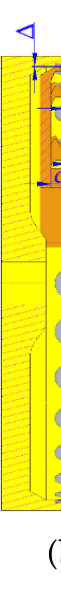
Figure 6. Schematic diagram of structure and installation of the seed-cleaning scraper. ( a ) Schematic diagram of the structure of the seed-cleaning scraper. ( b ) Schematic diagram of the relative position of the seed-cleaning scraper and the seeding plate. Note: a , front part’s width, mm; b , seed-cleaning part’s thickness, mm; R d , top radius of the seed-cleaning scraper, mm; ∆ , gap between the scraper top and annular groove inner wall, mm; c , extended length of the seed-cleaning part, mm; and ∆ l 1 , increment of extended length of two adjacent segment scrapers, (°).